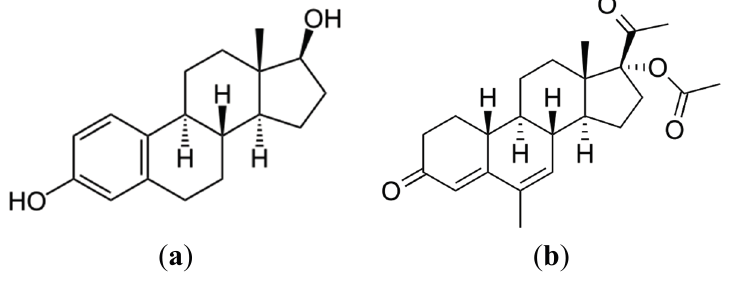
Figure 1. Chemical structures of the estrogens investigated: ( a ) 17- β estradiol and ( b ) Nomegestrol acetate.